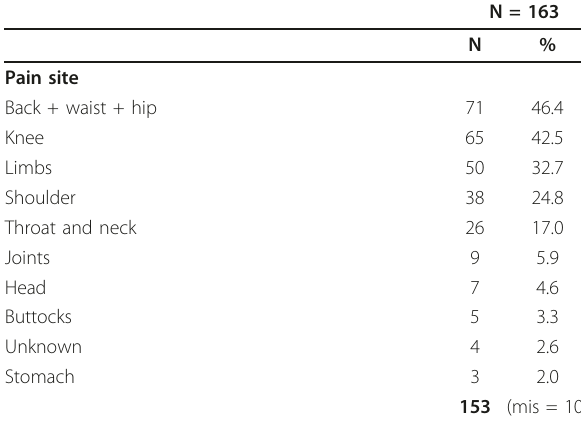
Table 1 Socio-demographic Data of the study population Table 2 Medical Characteristics for Patients with Pain